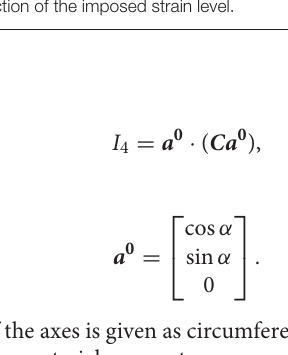
FIGURE 2 | Displacement-controlled protocol of a biaxial test. This part consists of five loading ratios with each ten preconditioning cycles and is repeated for several strain levels. The relative displacement in both circumferential and radial direction is defined with respect to the position at which preload has been reached and is given as a fraction of the imposed strain